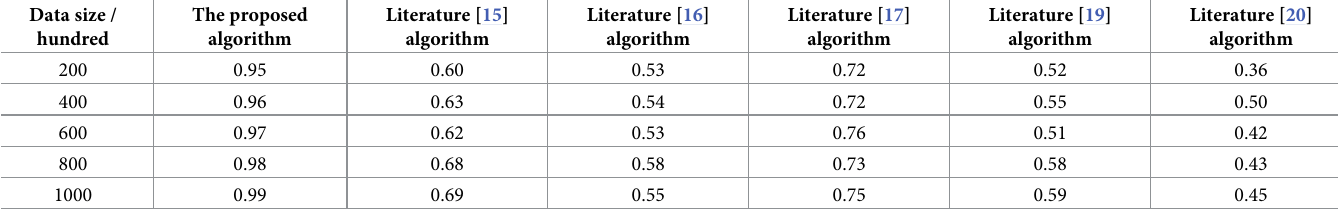
Table 1. Comparison of image segmentation